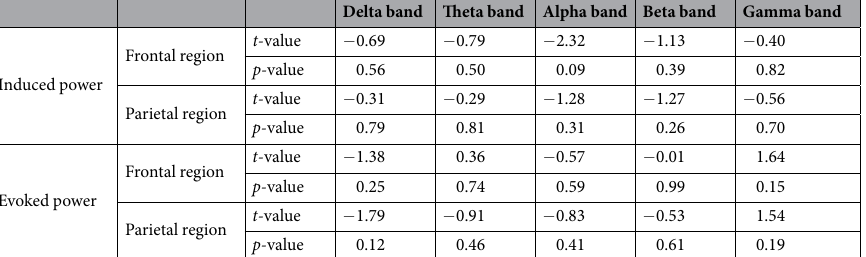
Table 1. Statistical values related to the TMS-induced/evoked spectral power. Note: N = 6; df = 5 for all tests.